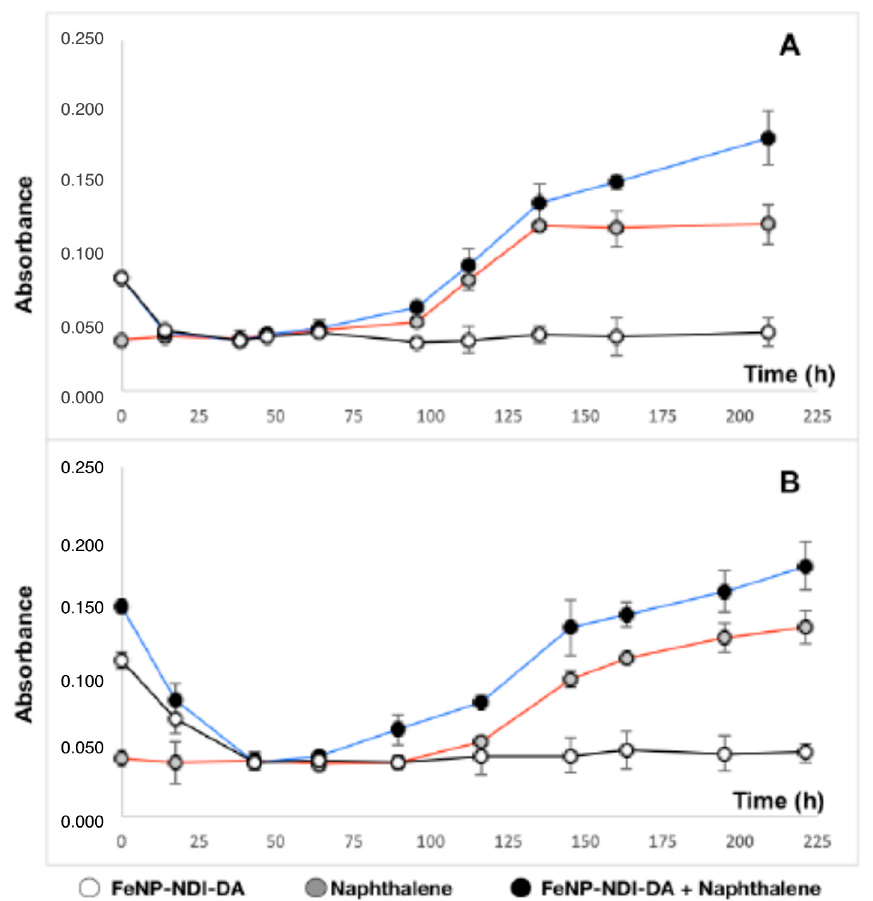
Figure 6. Growth (Absorbance, 595 nm) of S. aestuarii 357 with naphthalene (0.1% w / v ) as unique carbon and energy source supplemented with 100 mg/mL ( A ) and 200 mg/mL ( B ) of FeNP-NDI-DA. Growth values are average and SD of three different experimental replicates.